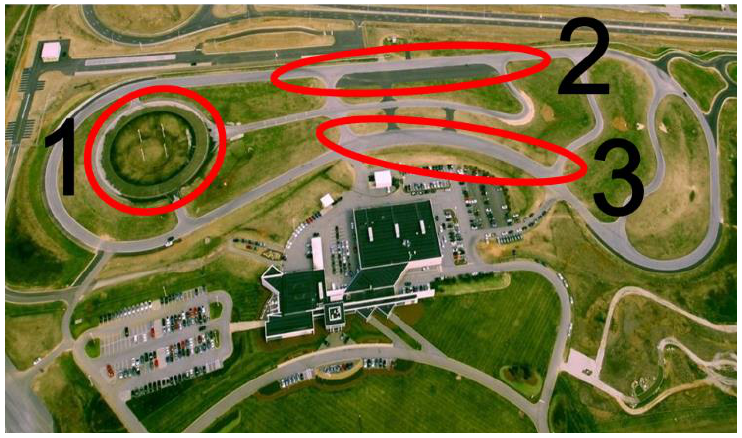
Figure 1. Aerial view of the track with the locations of the (1) skid recovery, (2) ABS braking, and (3) distraction exercises indicated.